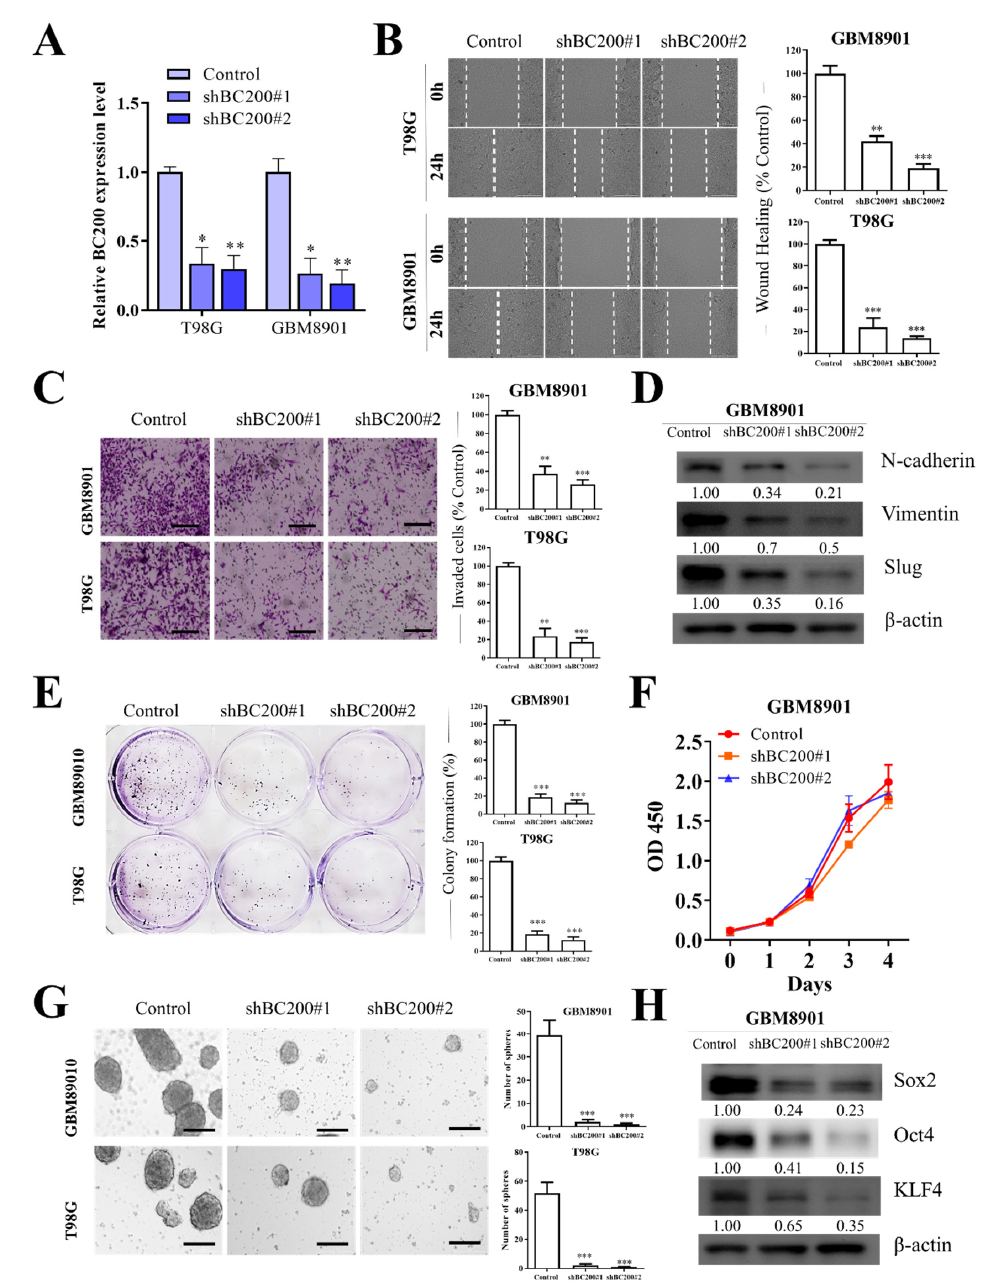
Figure 3. BC200 knockdown inhibited cell migration, invasion, colony formation, and sphere formation in GB cells in vitro. ( A ) The level of BC200 transfection with shBC200 was analyzed using RT-qPCR. ( B ) Wound-healing assay or migration assay showed that shBC200 resulted in delayed healing of the scratch wound. ( C ) Transwell invasion assay was used and results were expressed as the number of invaded cells per field. ( D ) The levels of N-cadherin, vimentin, and slug following shBC200 in GB cells were determined through western blot. ( E ) Colony formation assays showed that BC200 knockdown inhibited GB cell survival. ( F ) CCK-8 assay showed that BC200 knockdown had no e ff ect on GB cell proliferation. ( G ) Neurosphere formation assays showed that BC200 knockdown inhibited GB cell stemness. ( H ) The levels of SOX2, Oct4, and KLF4 following shBC200 transfection in GB cells were determined through western blot analysis. * p < 0.05, ** p < 0.01, and *** p <